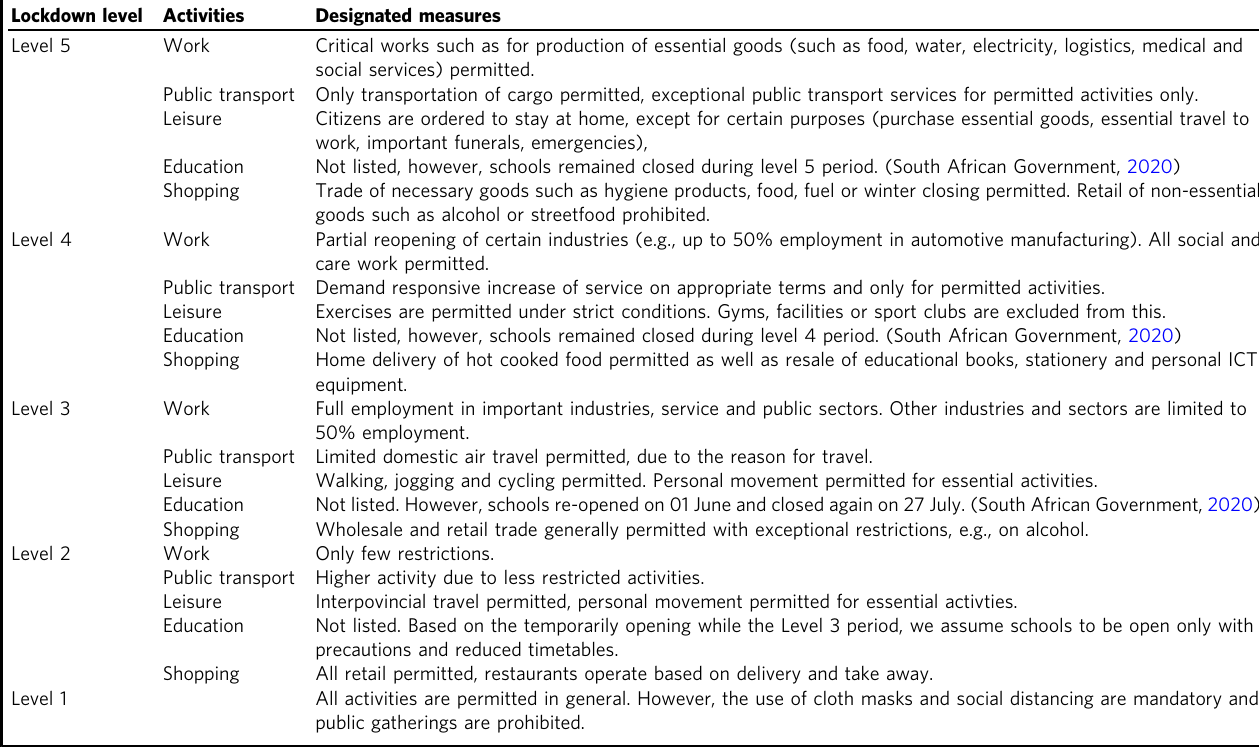
Table 4 Summary of the South African “ risk adjusted strategy ” for the activity types used in the epidemic